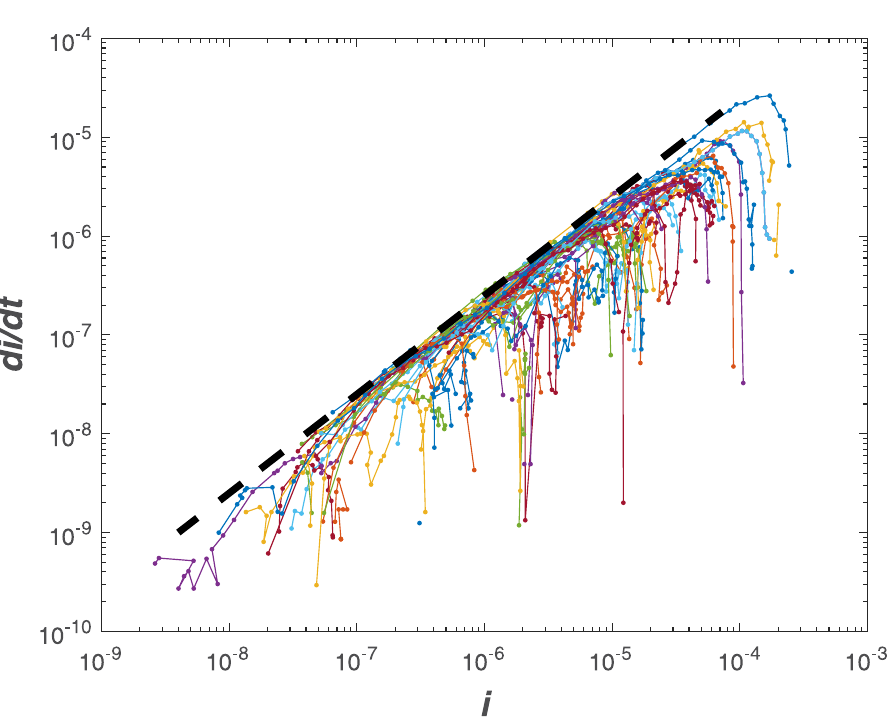
Fig 3. Comparison between di / dt and i for 57 countries. The dashed line is ( R d − 1 . Negative deviations from the dashed line reflect deviations from exponential in this phase-space representation.